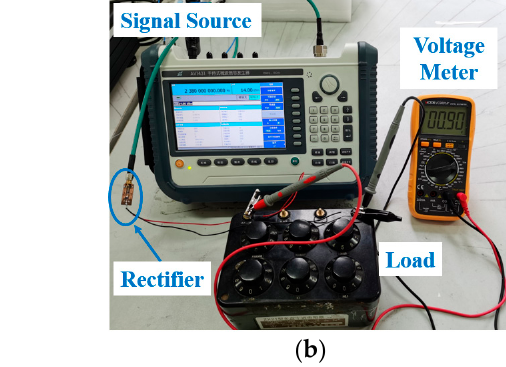
Figure 6. Measurement system of the rectifier: ( a ) schematic ( b ) actual.